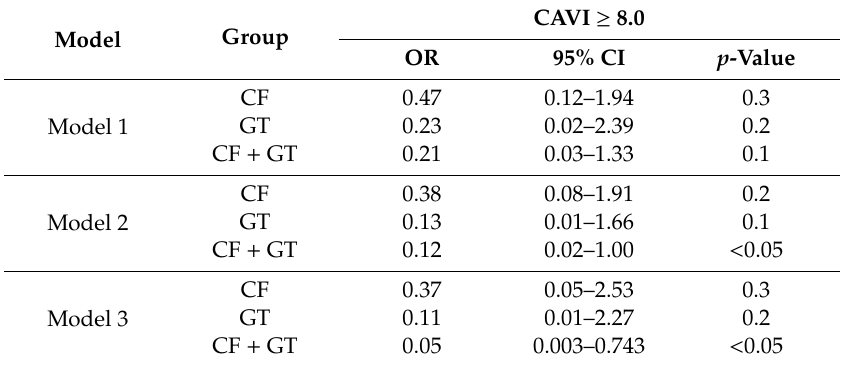
Table 3. Multivariate analysis of the associations of daily co ff ee (CF) and green tea (GT) consumption with high cardio-ankle vascular index (CAVI) in pre- / perimenopausal